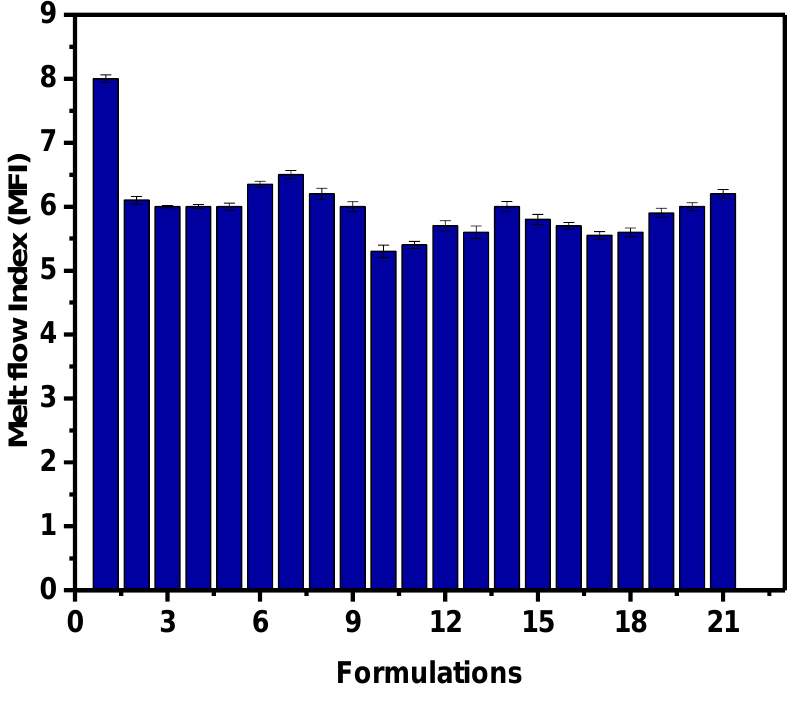
Figure 2. Melt flow index (MFI) of HDPE/filler composites.